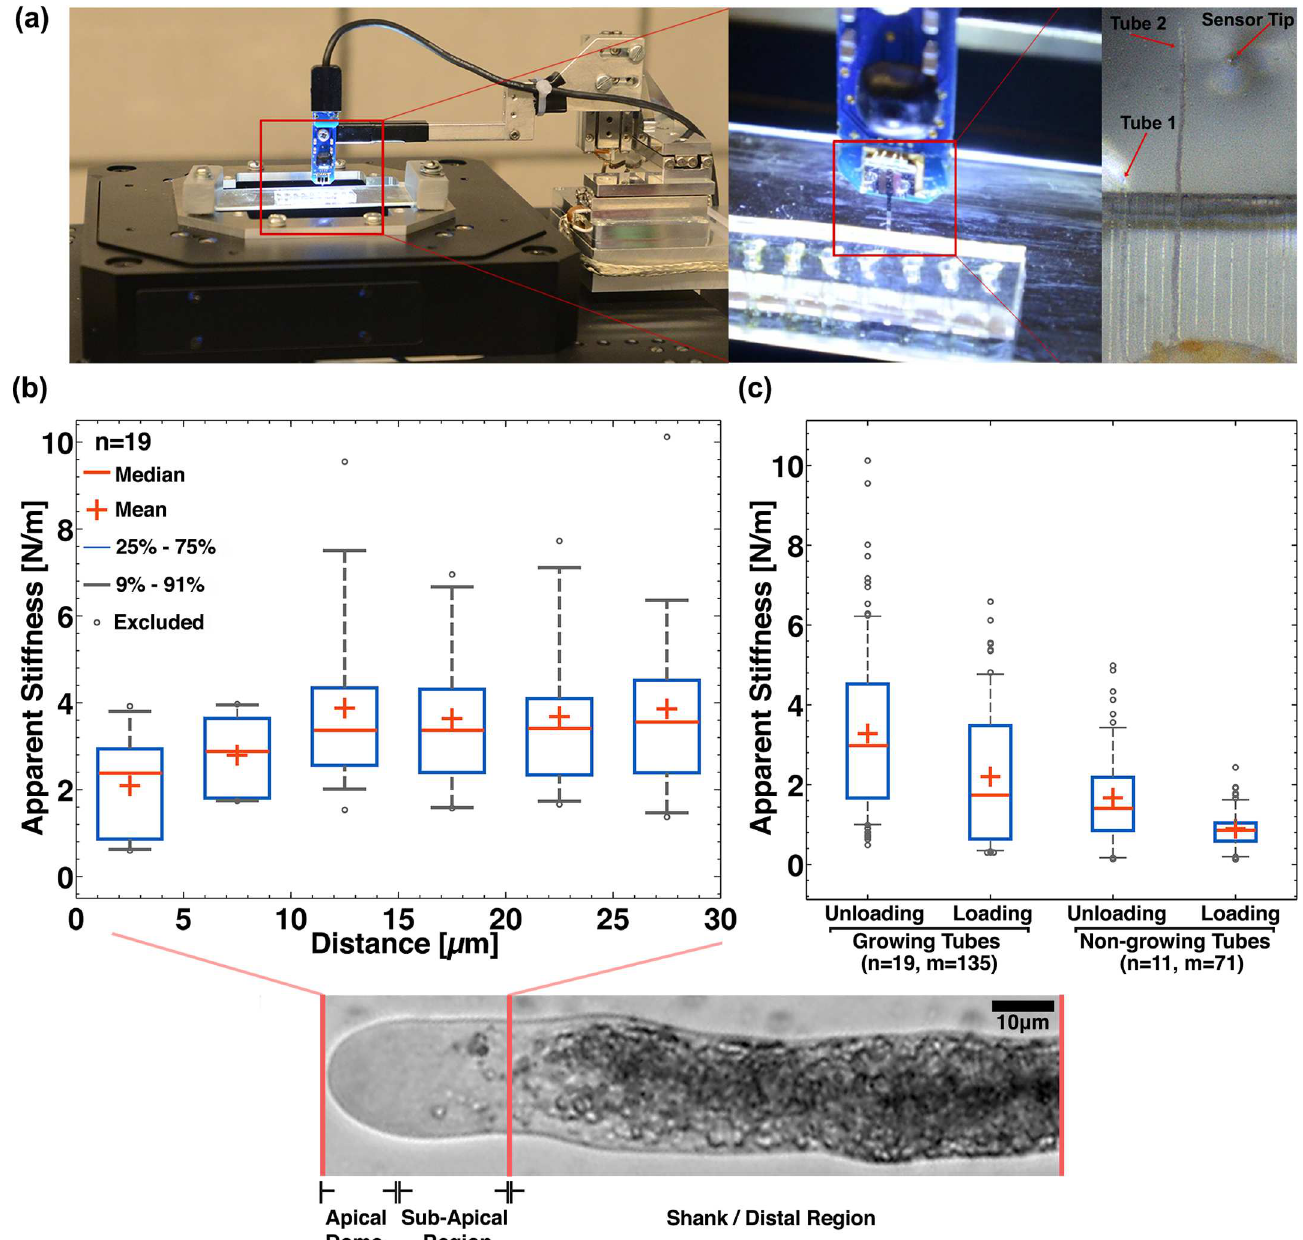
Fig 3. System integration of the LoC with the Cellular Force Microscope and micro-indentation dataset. (a) High-throughput micro-indentation measurements are possiblebecausedirectionally guidedtubes emerge out of the channels.(b) The apparentstiffness (unloading) of growingtubes is measuredalong the length of the tube near the apex region. (c) The apparentstiffness (loadingand unloading)of the shank area of growinglily tubes comparedto that of non-growing tubes. (n denotesthe numberof tubes and m denotesthe total numberof indentationson n